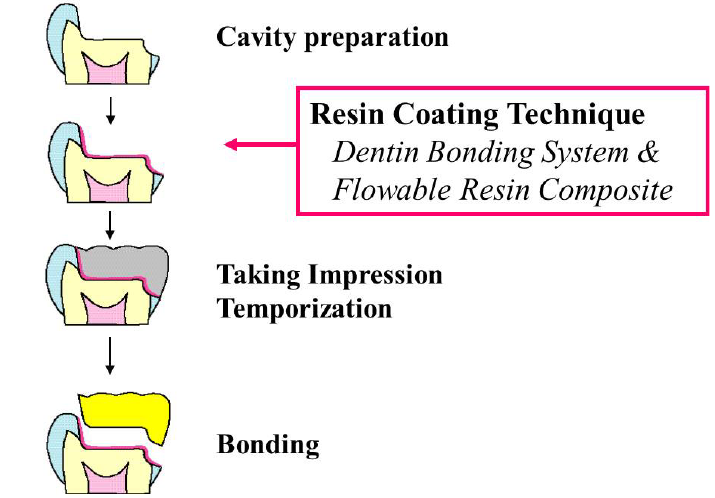
Figure 5. The clinical procedures of the resin coating technique. A combination of a dentin bonding system and a flowable resin composite is applied on the preparation just after cavity preparation and before taking the